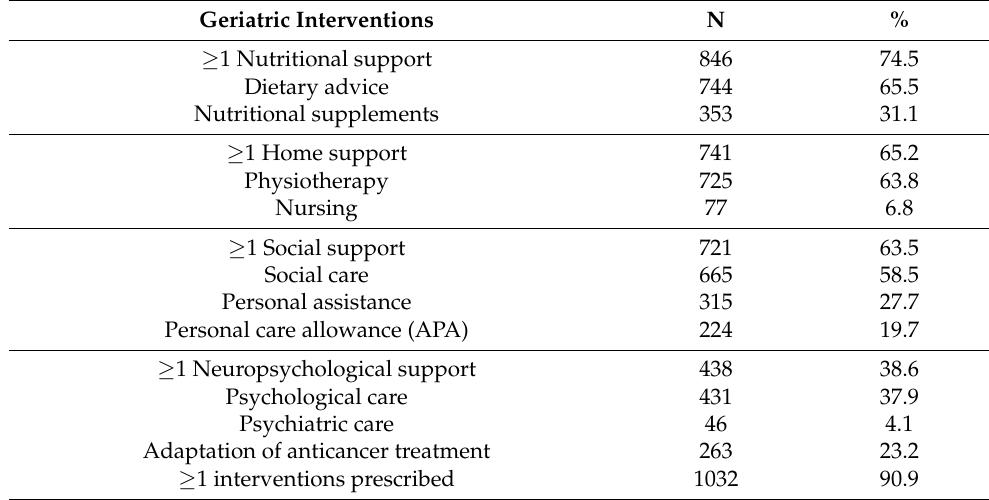
Table 2. Geriatric interventions for overall patient management.